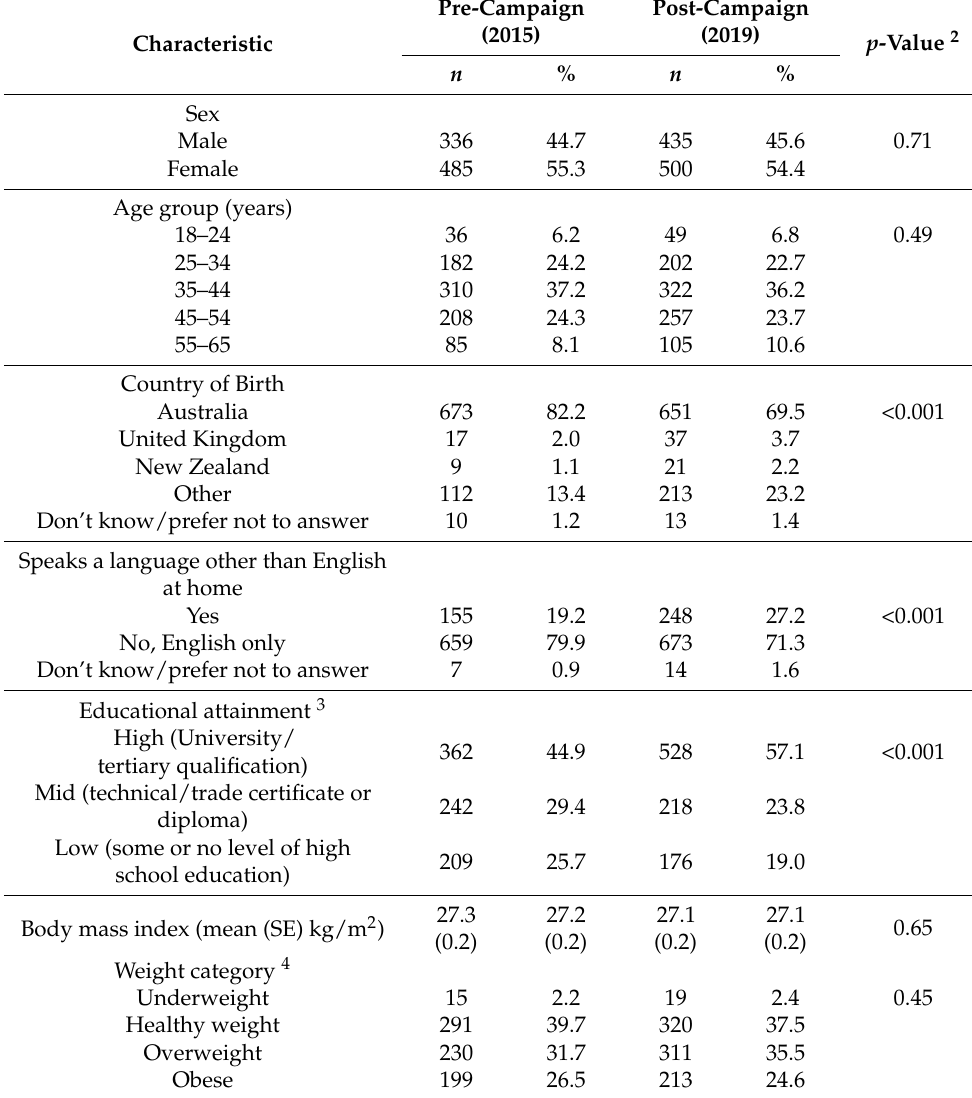
Table 2. Demographic characteristics of parents with children aged <18 years pre- ( n = 821) and post-campaign ( n = 935) 1 showing unweighted numbers and